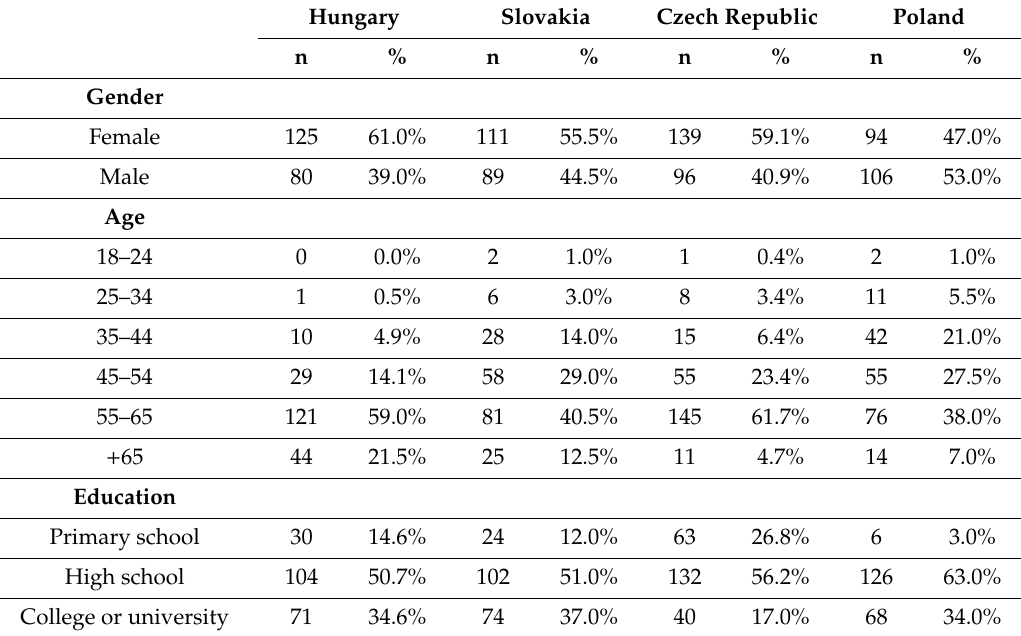
Table 1. Demographic characteristics of the study